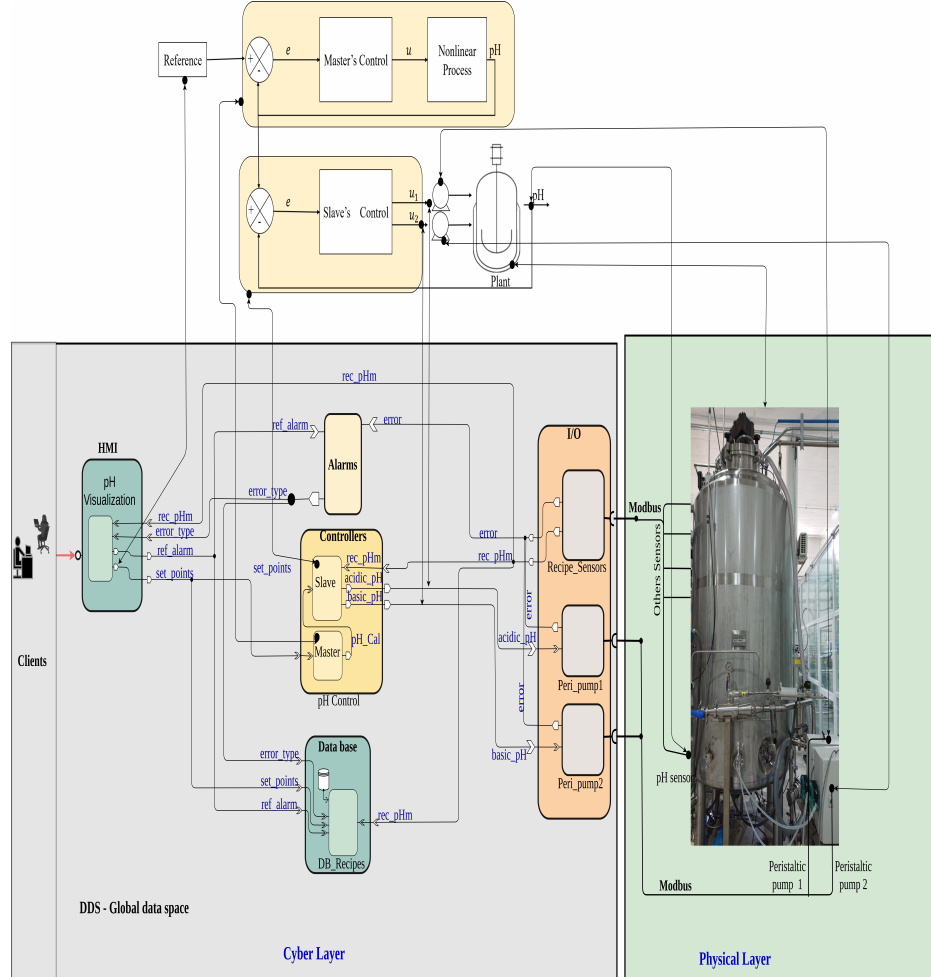
Figure 5. Component-Based DDS architecture design for pH